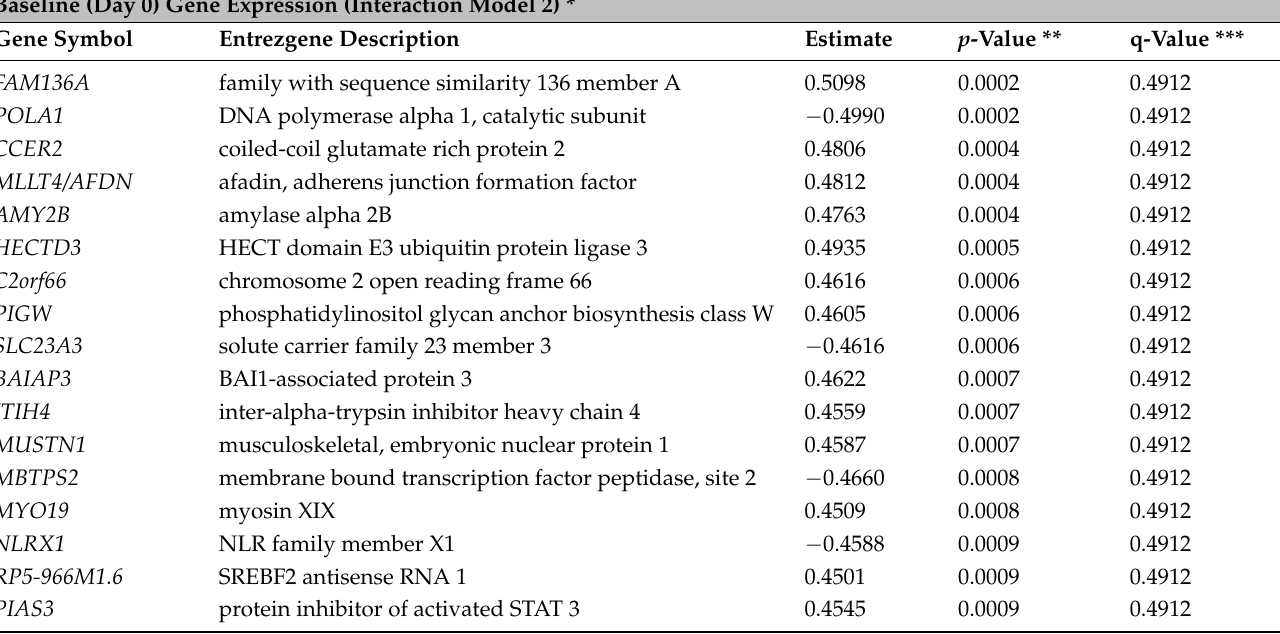
Table 3. Influence of CD4+ T cell gene expression (Day 0 or Day 28) on Ab response to influenza vaccination by vaccine